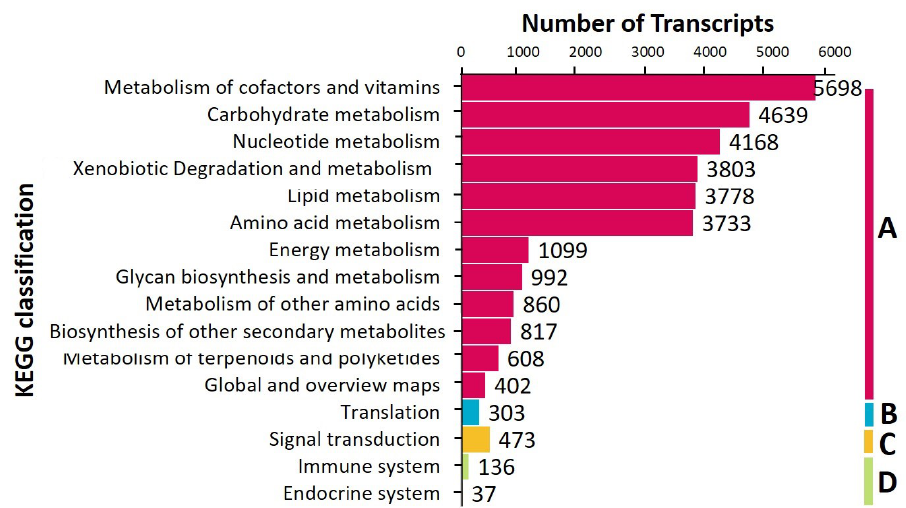
Figure 6. KEGG Pathway classification of M. plana ’s transcriptomes. ( A ) Metabolism, ( B ) genetic information processing, ( C ) environmental information processing, ( D ) organismal systems.